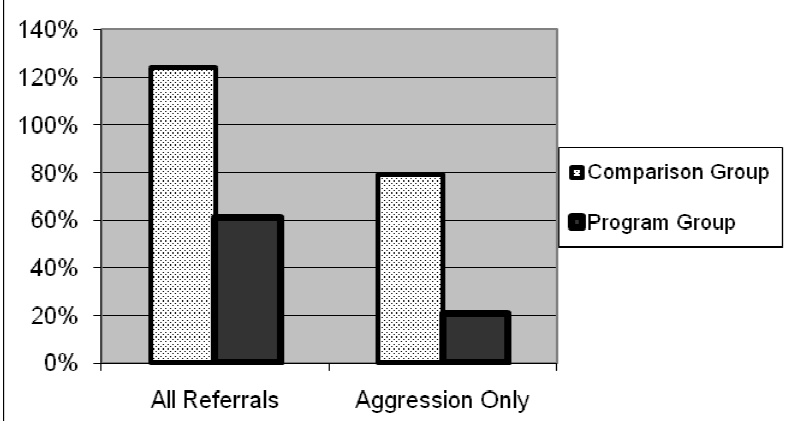
Change in Rate of Disciplinary Referrals from Dec 2007 to May